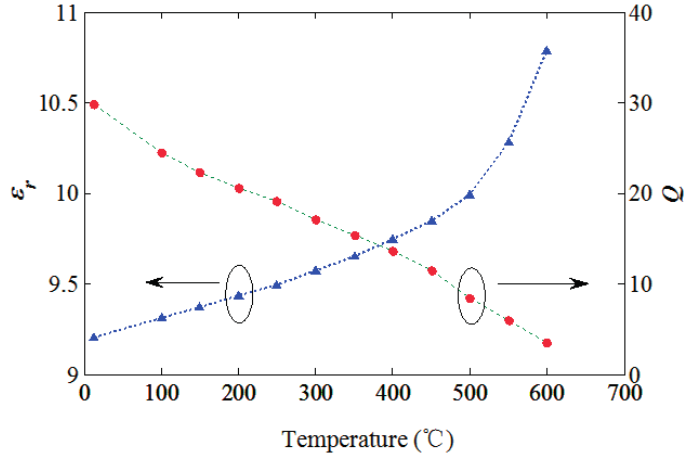
Figure 9. Relative permittivity and Q versus